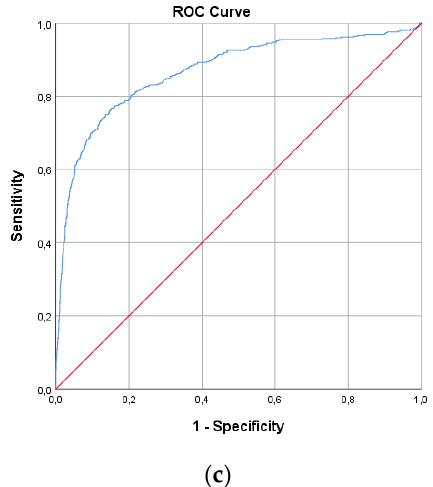
Figure 1. ROC curve of the general agricultural model of Slovak enterprises. ( a ) ROC curve in 2018; ( b ) ROC curve in 2017; ( c ) ROC curve in 2016.